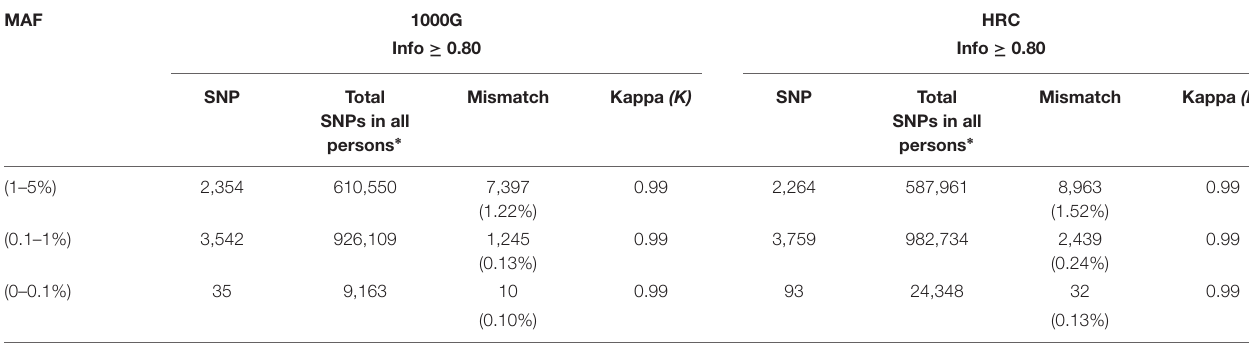
TABLE 4 | Comparison for mismatch counts and Kappa ( K ) for HRC and 1000G using WES data on Chromosome 14. MAF 1000G HRC Info ≥ 0.80 Info ≥ 0.80 Total Kappa SNPs in all